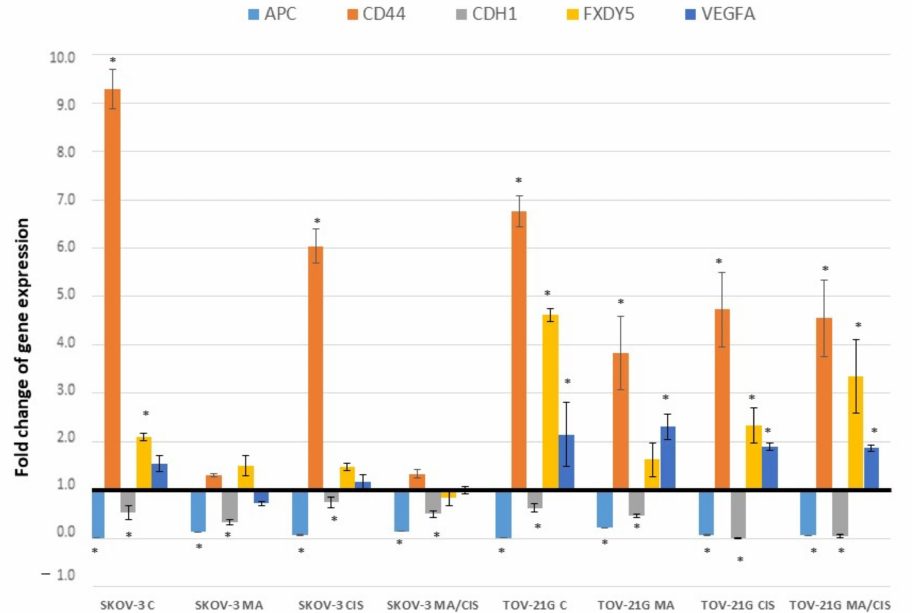
Figure 1. Effect of exosomes derived from SKOV-3 and TOV-21G cells (untreated with drugs, α - mangostin and/or cisplatin-treated) on the expression of cell adhesion markers in fibroblasts. The data are shown as mean ± SD of triplicate experiments, statistically significant results * ( p <